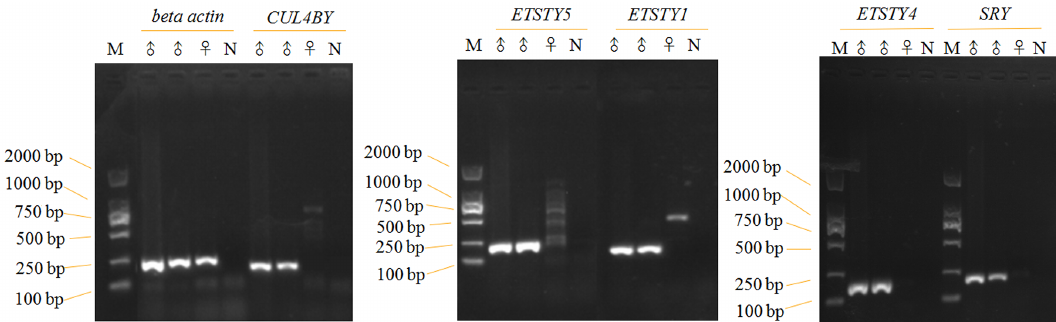
Figure 1. Gel electrophoresis of PCR products of six donkey genes. The primers of these five Y-linked genes amplified male-specific bands with expected fragment size labeled above the band. M: 2kb DNA ladder; ♂ : male donkey genomic DNA; ♀ : female donkey genomic DNA; N: negative control (distilled water).